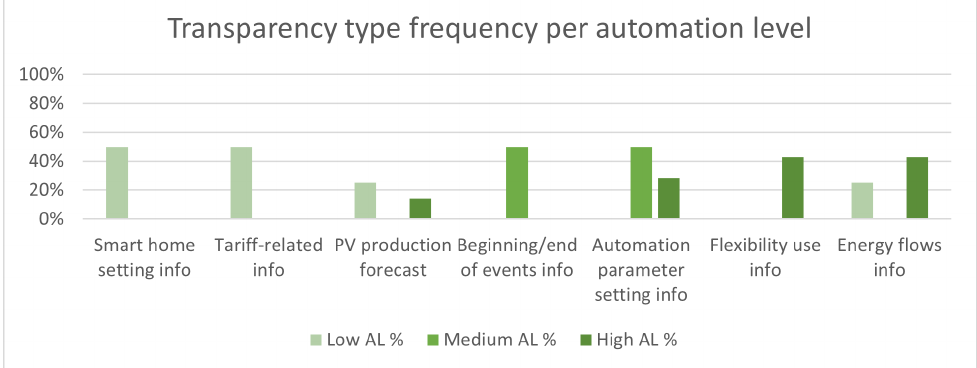
Figure 4. Transparency per automation level.